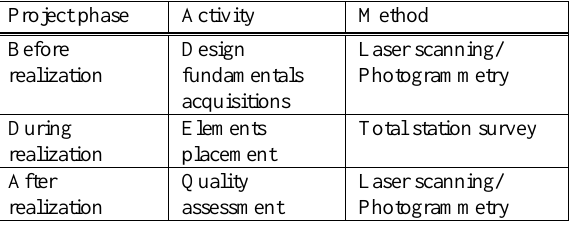
Table 1. Geomatics integration into various project phases Description of ideal project workflow: